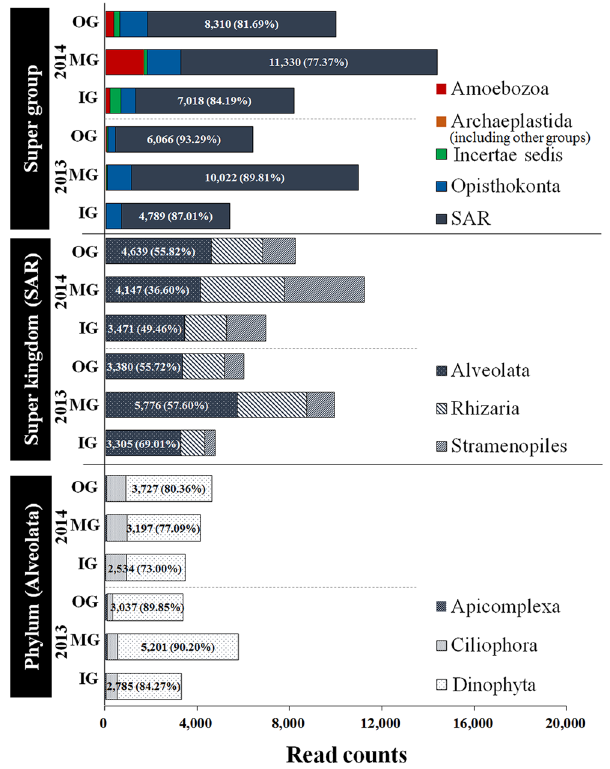
Figure 1. Taxonomic distribution of super group, super kingdom, and phylum levels revealed by next- generation sequencing analysis in surface sediments of Tongyeong coast (South Sea) of South Korea during December 2013 and September 2014. IG, inner group; MG, middle group; OG, outer group; SAR, Stramenopiles-Alveolata-Rhizaria super